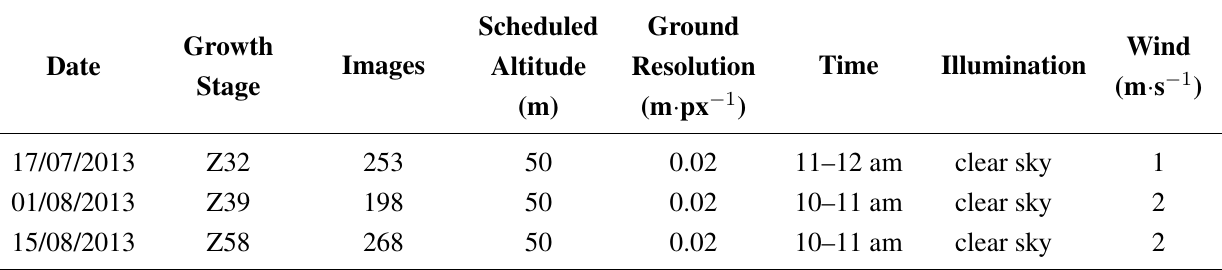
Table 1. Overview of performed flight missions at Zadoks’ scale’s crop growth stages Z32, Z39 and Z58 and the number of images for subsequent processing, flight altitude, approximate image ground resolution, mission time, illumination and wind